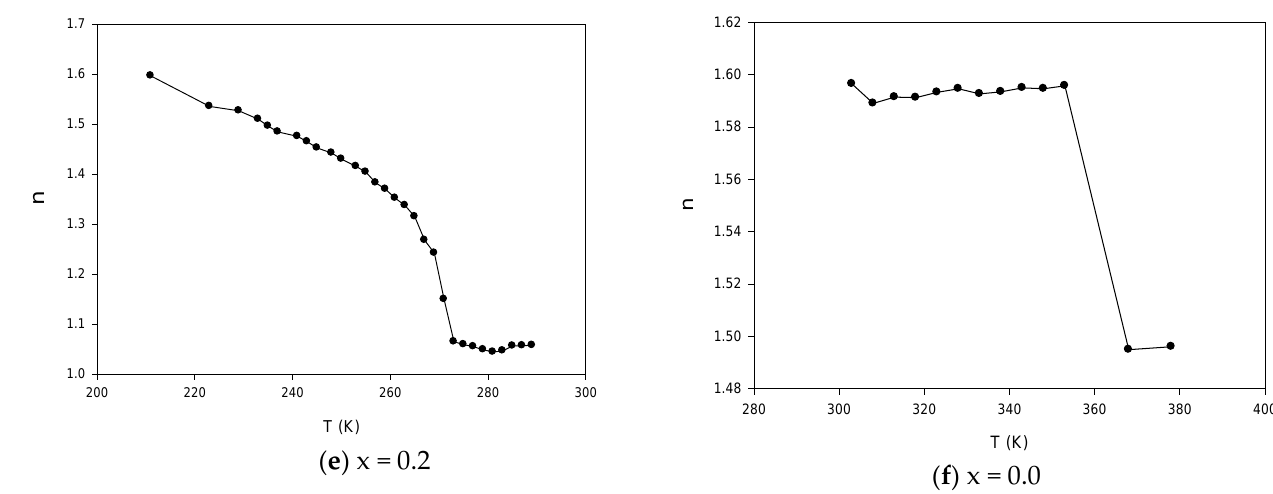
Figure 8. ( a – f ): The variation of exponent (n) for the composites of (PVDF-BZT) as a function of the temperature at 10 kHz.